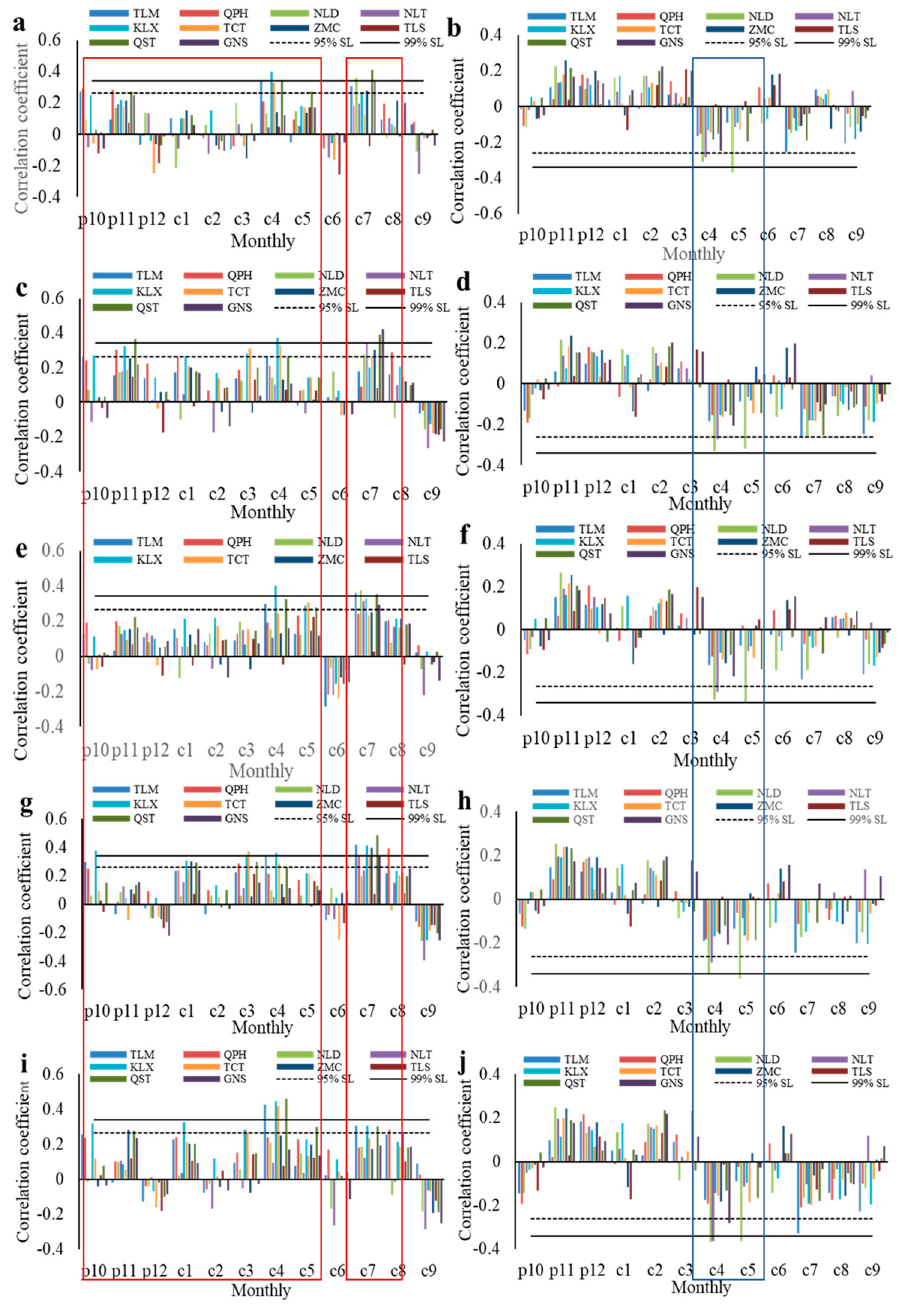
Figure 3. Correlation coefficients between the radial growth of trees and climate parameters along the Upper Ili River, China (1960–2014). ( a ) Monthly precipitation at Gongliu station; ( b ) monthly temperature at Gongliu station; ( c ) monthly precipitation at Xinyuan station; ( d ) monthly temperature at Xinyuan station; ( e ) monthly precipitation at Nileke station; ( f ) monthly temperature at Nileke station; ( g ) monthly precipitation at Tekesi station; ( h ) monthly temperature at Tekesi station; ( i ) monthly precipitation at Zhaosu station; ( j ) monthly temperature at Zhaosu station. The red box indicates the month in which the radial growth of trees is related to precipitation. The blue box represents the months in which the radial growth of trees is significantly correlated with tempera- ture.